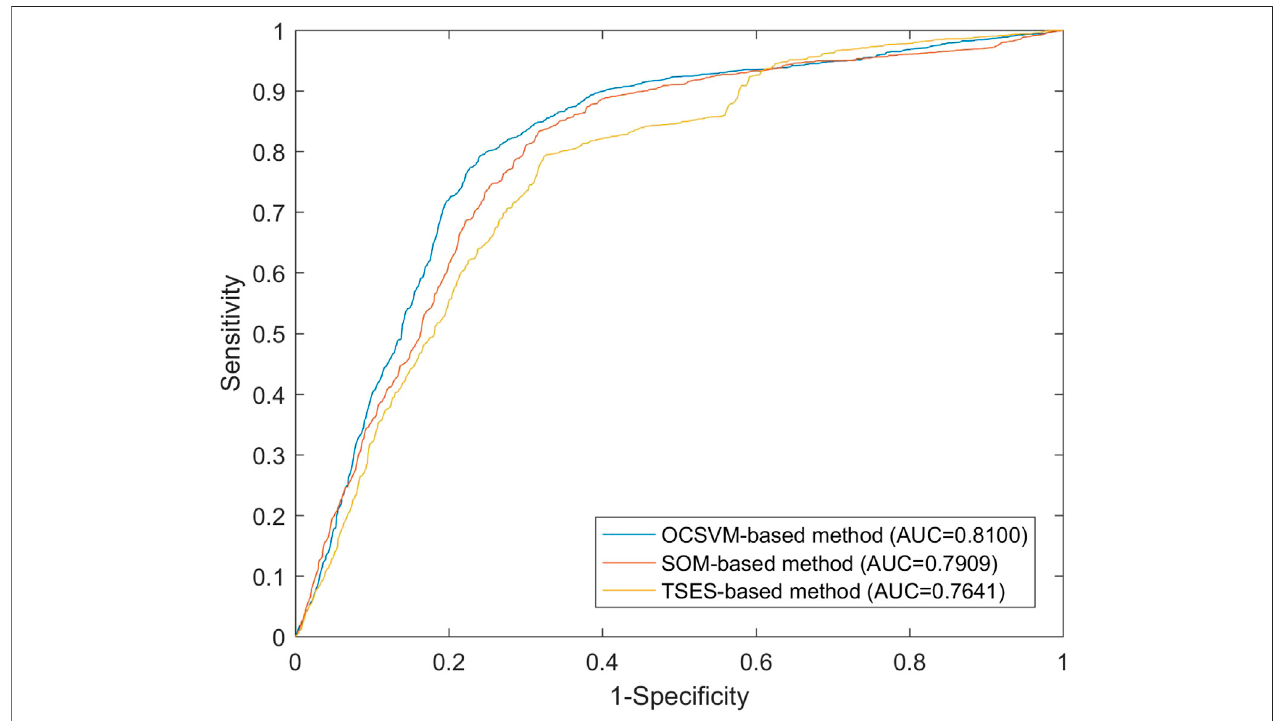
FIGURE 10 | ROC curves of the presented method based on three OCCs.